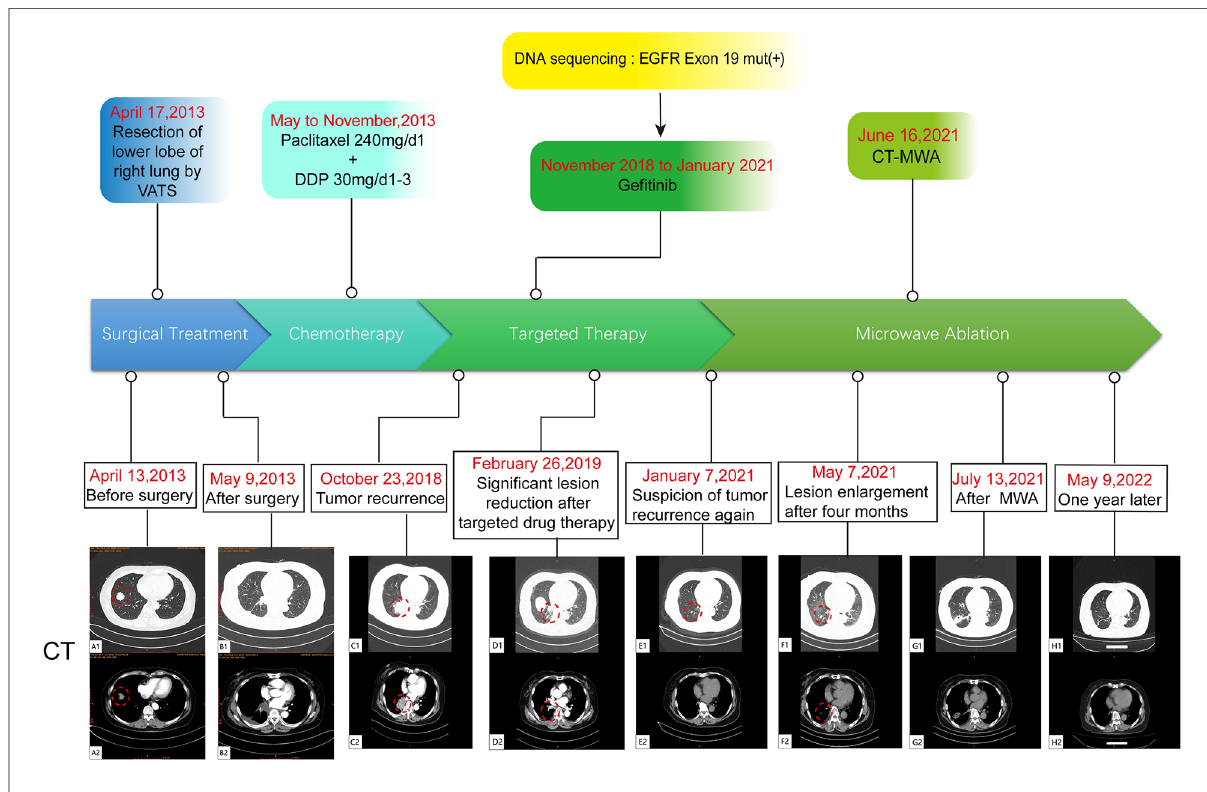
FIGURE 1 A fl ow chart of the entire treatment course. Red circles indicate the target lesion. VATS, video-assisted thoracic surgery; DDP, cis- diamminedichloroplatinum; CT-MWA, CT Guided Microwave